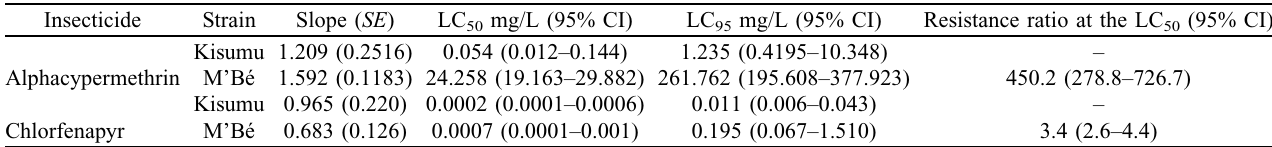
Table 1. Resistance status of Anopheles gambiae s.l . from M’Bé to the two insecticides present in the Interceptor (cid:2) G2 LN (i.e. alpha- cypermethrin and chlorfenapyr).